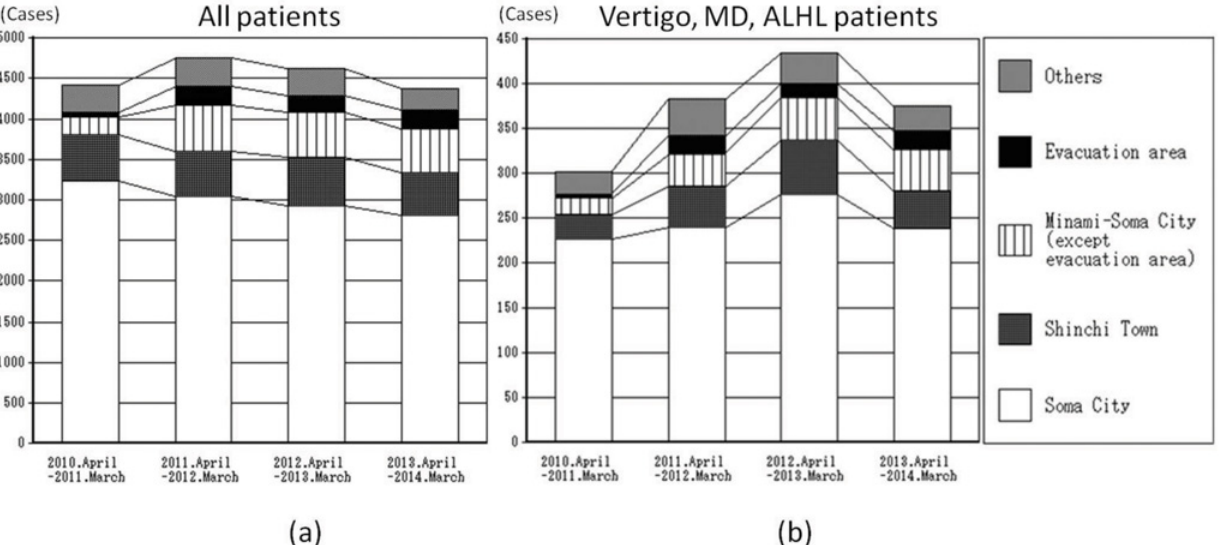
Fig 4. Investigation of the new ENT patients from April to the following March by living area. (a) For all new patients, the number from Soma City decreased, but that from Minami-Soma City and other evacuation areas increased. (b) Those with vertigo, MD, and ALHL increased in each area. In Soma City and Shinchi Town, the number peaked in the second year and showed a slight decrease in the third year. On the other hand, the number of new patients in Minami-Soma City and the evacuation areas remained about the same.